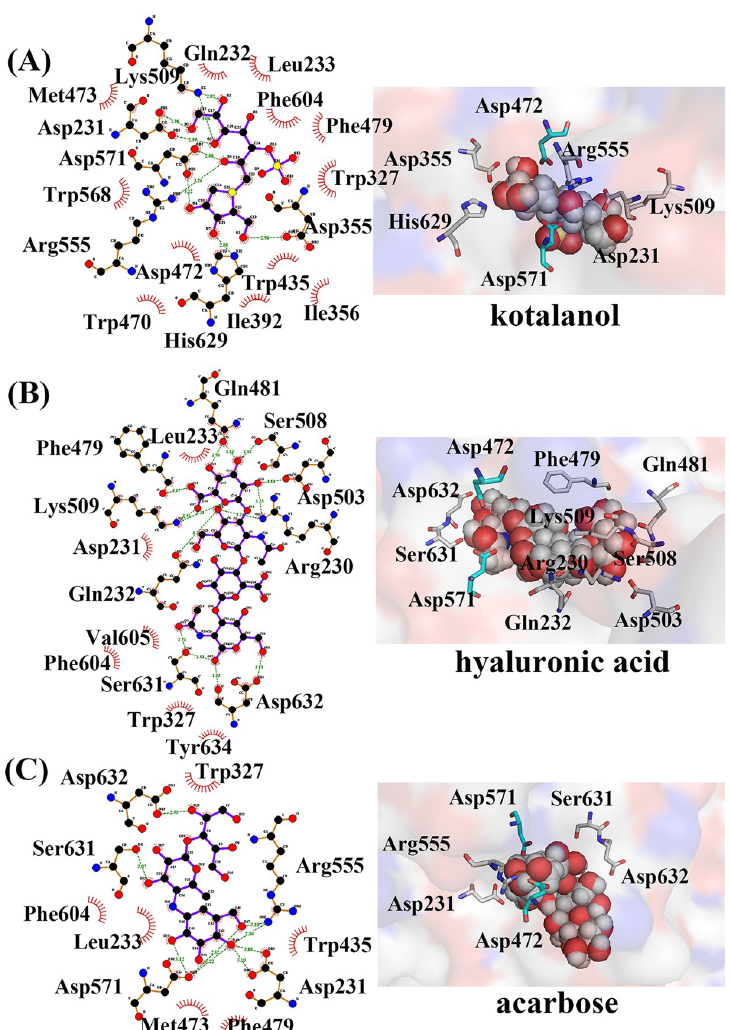
Fig 2. (A) The docking pose of SI-acarbose. (B) The docking pose of SI-kotalanol. (C) The docking pose of SI-HA.